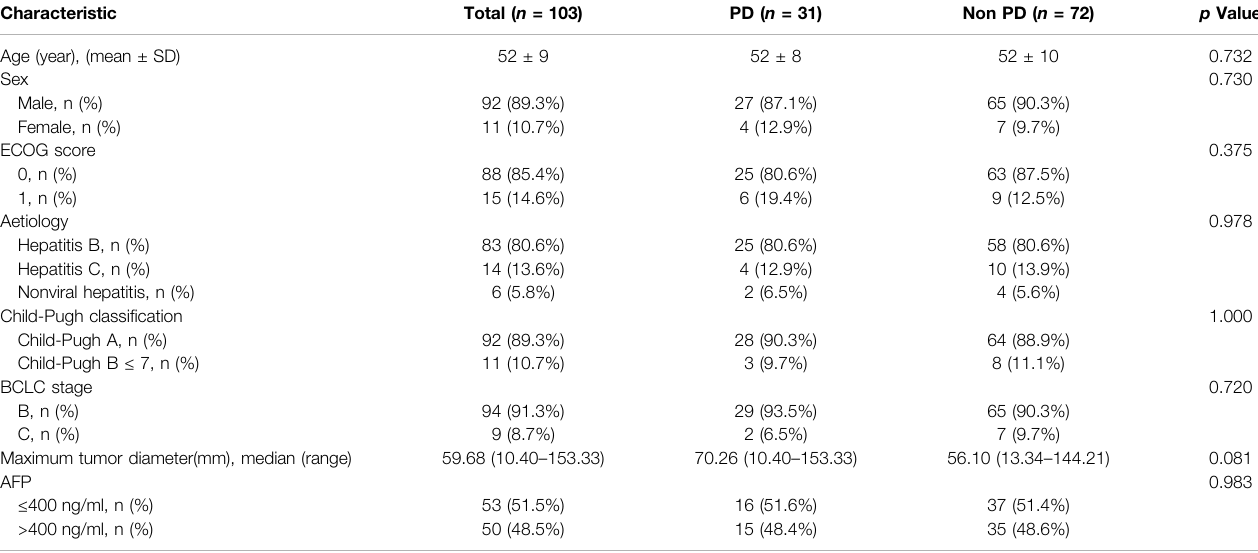
TABLE 1 | Baseline demographic and clinical characteristics of patients.